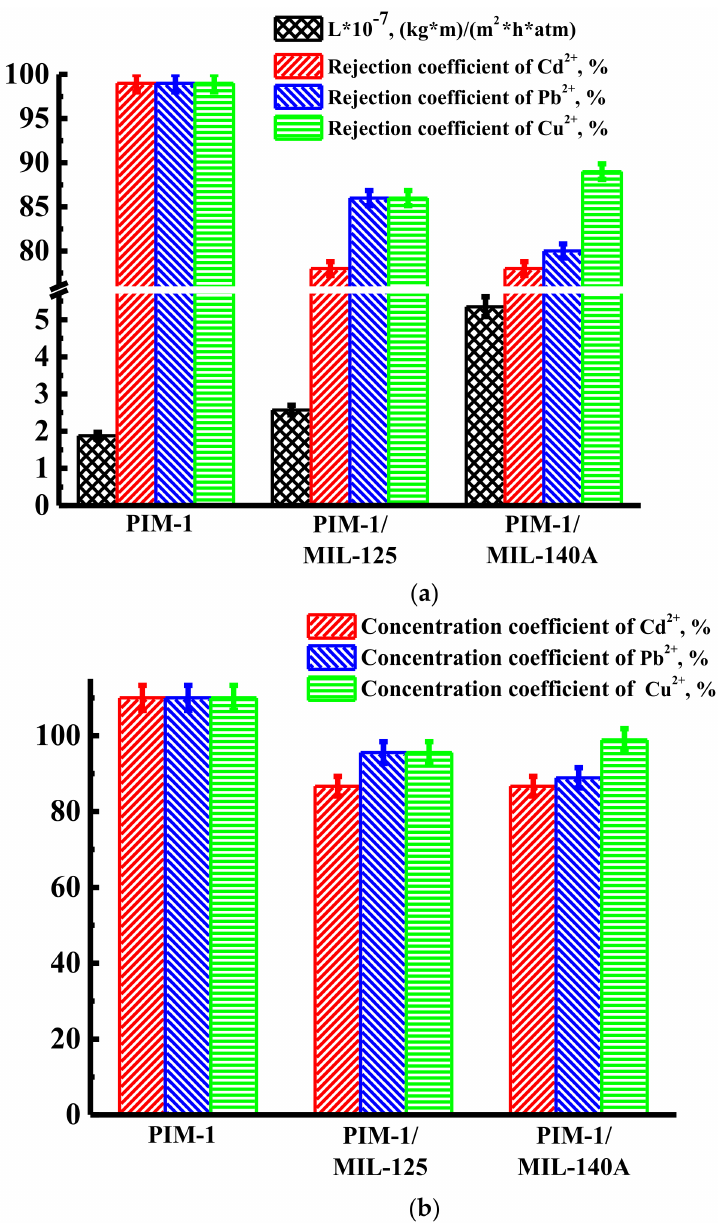
Figure 5. Transport properties: ( a ) permeability and rejection coefficients and ( b ) concentration coefficients during nanofiltration of the solution containing a mixture of heavy metal ions (Cd 2+ , Pb 2+ , Cu 2+ ) at 50